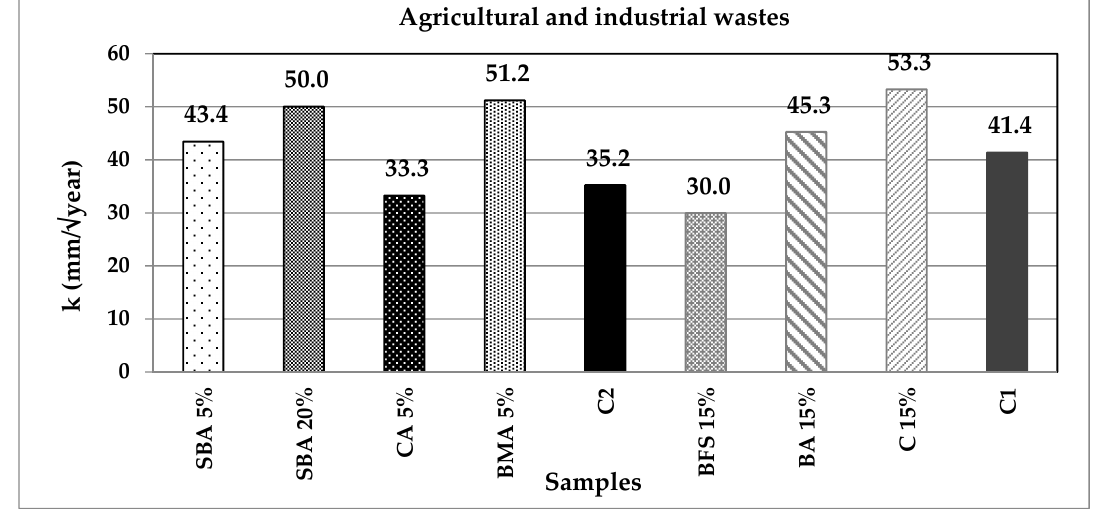
Figure 13. Constant k for the agricultural and industrial wastes group of additions.